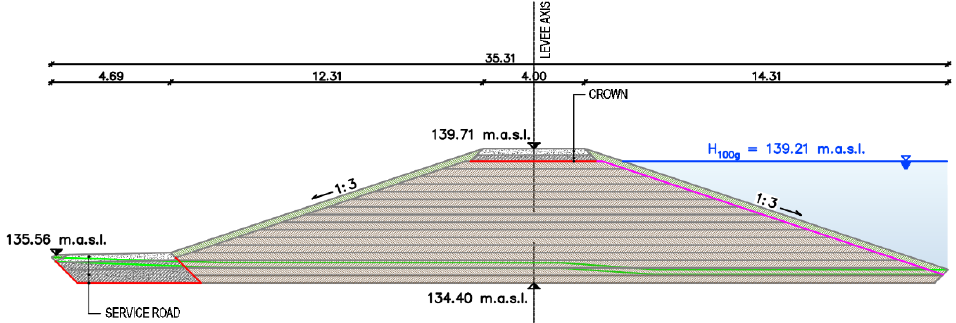
Figure 4. A cross-section of the case study levee.